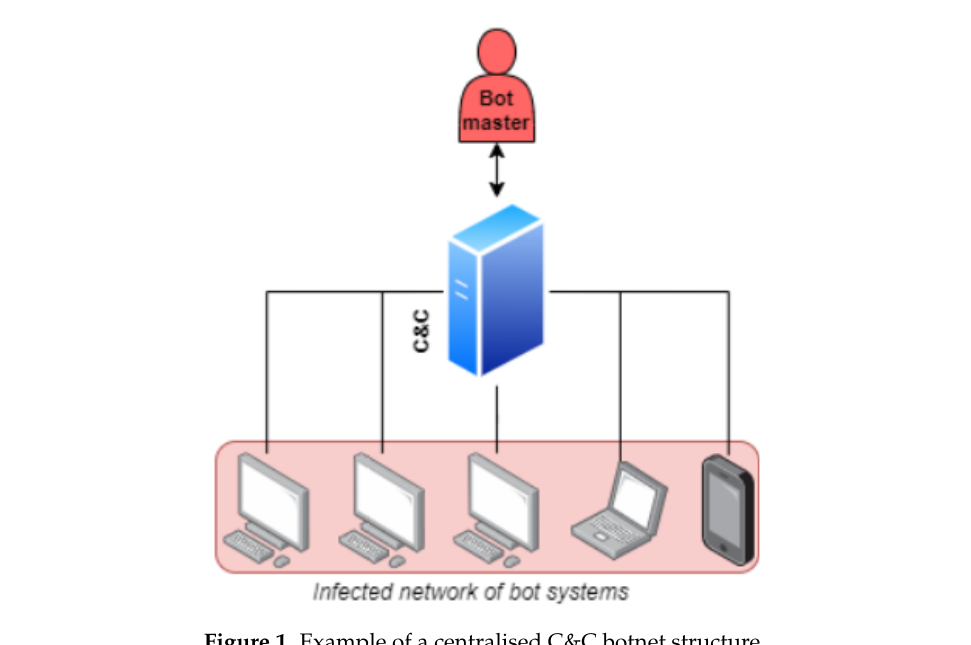
Figure 1. Example of a centralised C&C botnet structure.